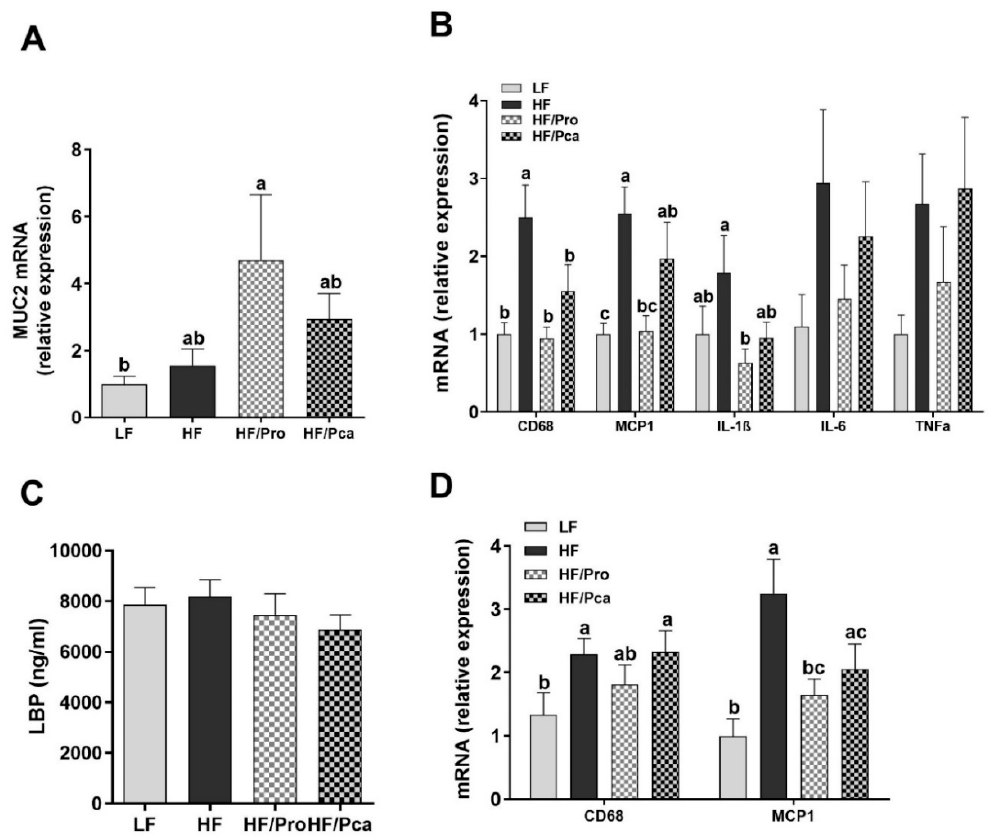
Figure 5. Non-encapsulated probiotic supplementation improved markers of gut integrity and inflammation. Gene expressions of MUC2 ( A ) and inflammatory markers ( B ) in the ileum, serum LBP ( C ), and gene expression of macrophage infiltration markers ( D ) in mesenteric fat of rats fed an LF, HF, HF / Pro, or HF / Pca diet for seven weeks. Values are means ± SEMs; n = 8 / group. a,b,c means with di ff erent letters are statistically significant, p < 0.05. CD68, cluster of di ff erentiation 68; HF, high fat; IL-1 β , interleukin-1 beta; IL-6, interleukin-6; LBP, lipopolysaccharides-bind protein; LF, low fat; MCP1, monocyte chemoattrantant protein 1; MUC2, mucin 2; HF / Pca, HF with supplemented with encapsulated L. casei W8 (4 × 10 7 cfu / g diet); HF / Pro, HF supplemented with non-encapsulated L. casei W8 (4 × 10 7 cfu / g diet); TNF α , tumor necrosis factor alpha.